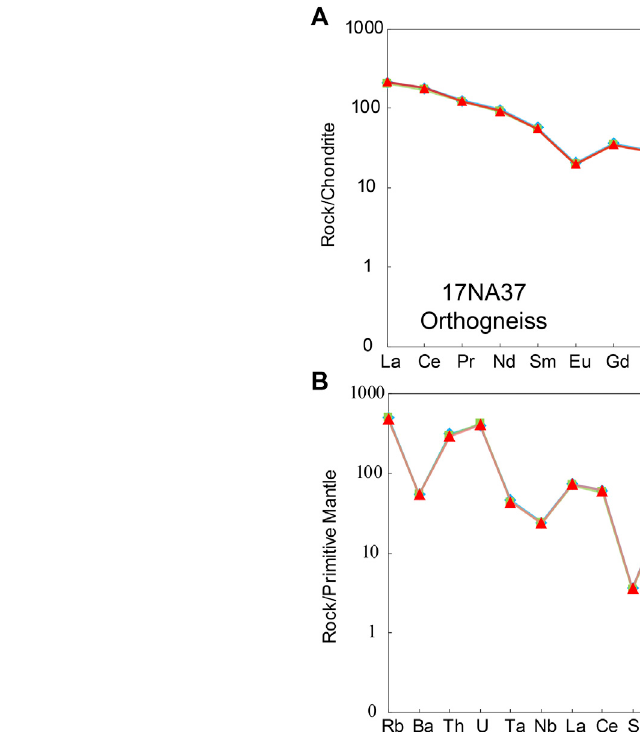
Frontiers in Earth Science |